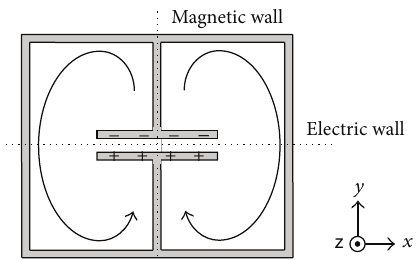
Figure 3: Typical topology of an ELC resonator, indicating the electric and magnetic walls and a sketch of the currents and the charge distribution at the fundamental